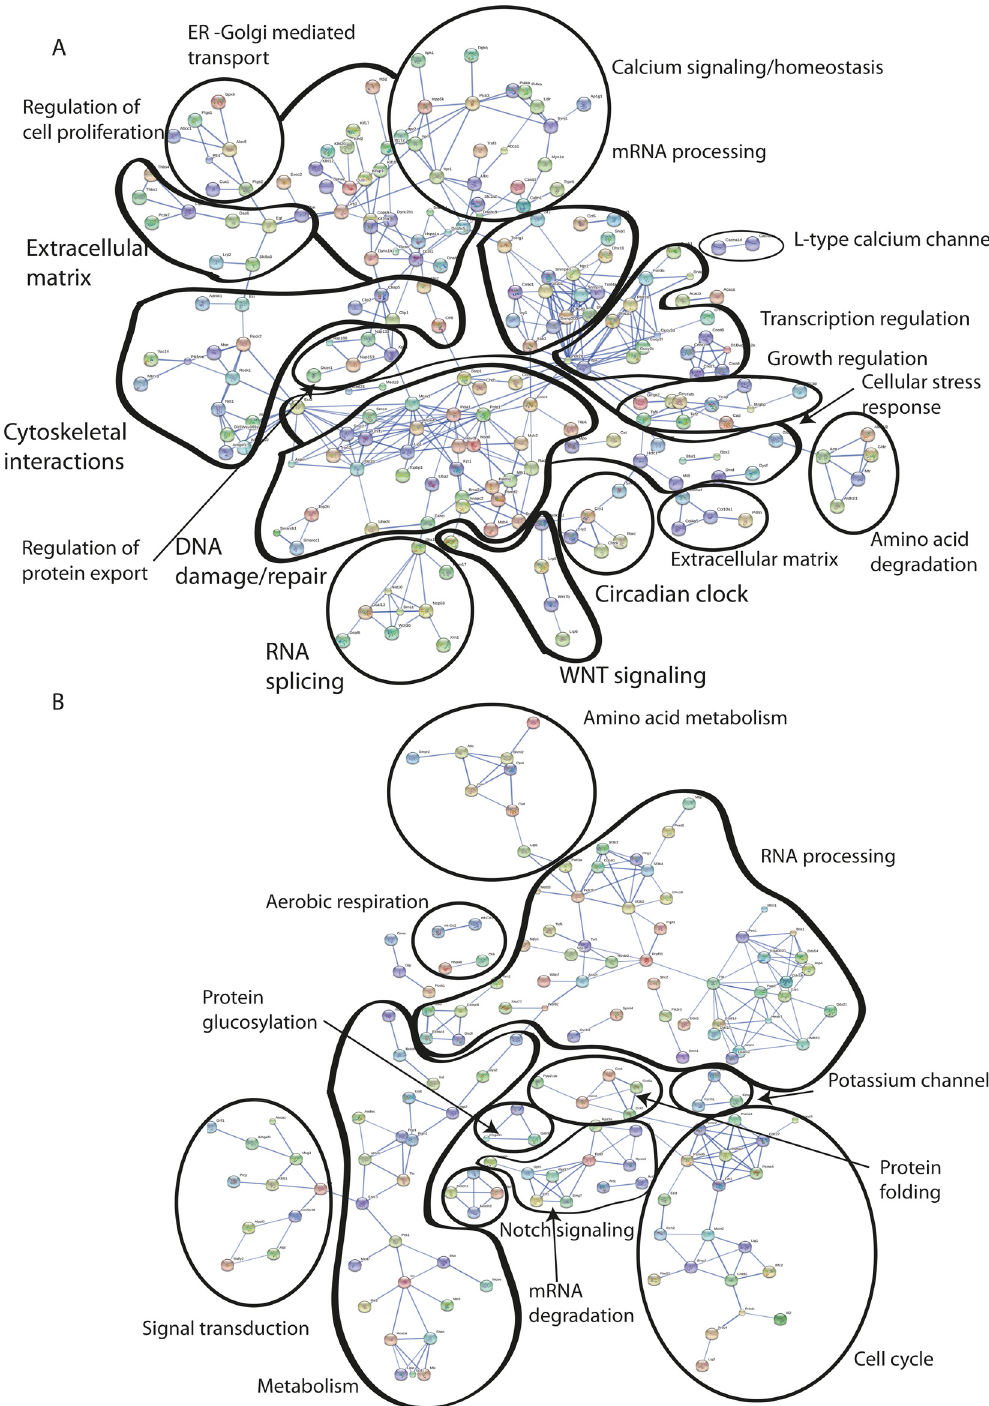
Fig 3. Protein interaction networks. Protein interaction network of genes that were up regulated (A) and down regulated (B) in Representative Concentration Pathway RCP8.5 Acropora millepora holobiont. The DEG list of the RCP8.5 vs Present Day (PD) conditions comparison was uploaded to the STRING (Search Tool for the Retrieval of Interacting Genes) database. Protein interactions are categorized according their Gene Ontology classifications.